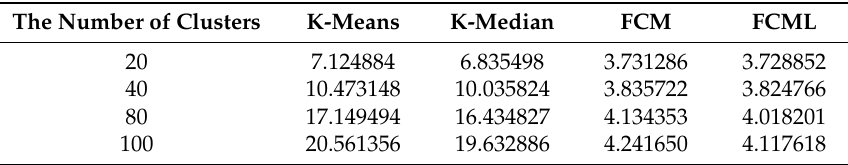
Table 1. The average computational time (in minutes) of the clustering algorithms for real-world taxi GPS datasets. The Number of Clusters K-Means K-Median